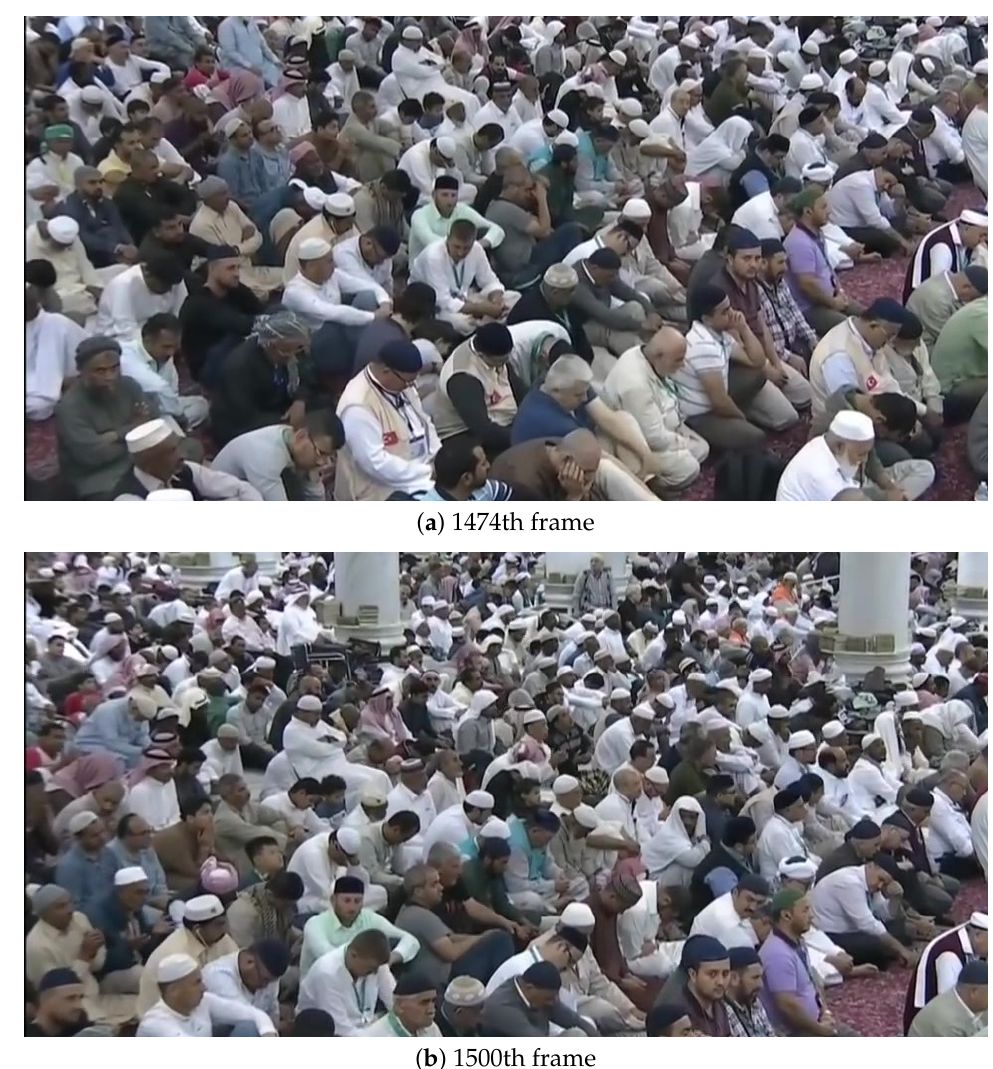
Figure 1. Sampled frames of a video sequence showing the large crowd gathering in Al Nabvi mosque, Madinah